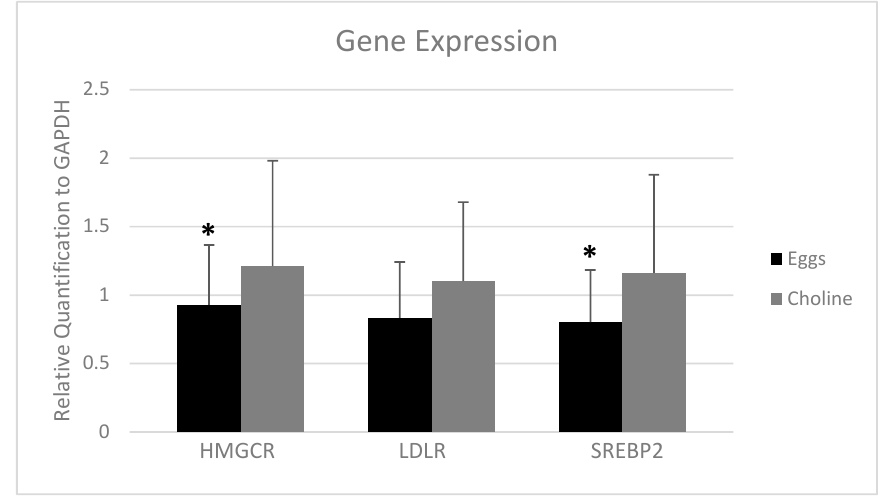
Figure 2. Gene expression of 3-hydroxyl-3-methyl-glutaryl-coenzyme A reductase (HMGCR), low- density lipoprotein receptor (LDLR) and sterol regulatory element-binding protein 2 (SREBP2) with intake of 3 eggs versus choline bitartrate supplement for 4 weeks each. Data were standardized to the expression of GAPDH as a reference gene using the 2 ( −ΔΔ C t) method. Values are presented as mean ± SD for n = 27 men and women. Bar with superscripts differ at p < 0.05 as determined by paired Student’s t test after excluding outliers using Grubb’s test.